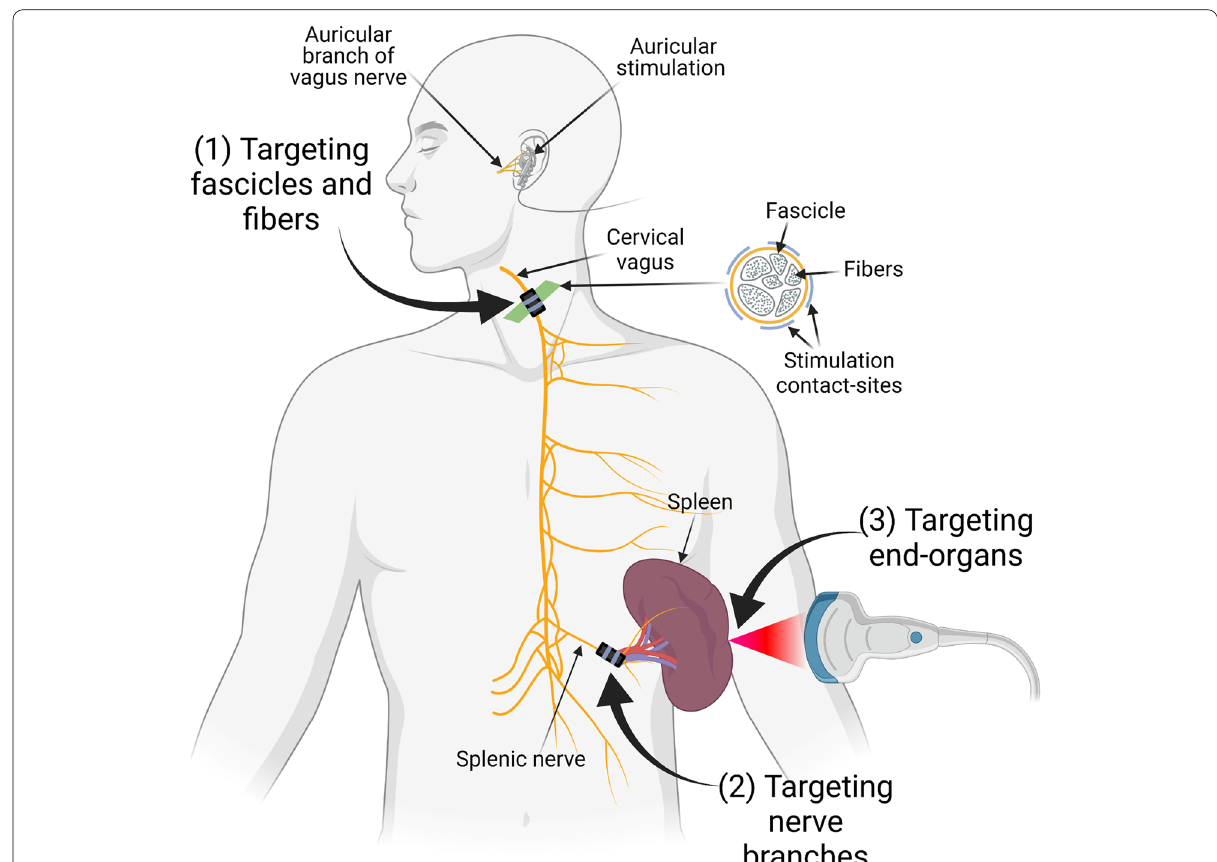
Fig. 1 Illustration of strategies for precision vagus neuromodulation. The first strategy is to selectively stimulate fascicles and fibers of the vagus nerve at the cervical level. The second strategy is to stimulate the near‑organ branch of the vagus. The third strategy is to directly stimulate the nerve endings at the